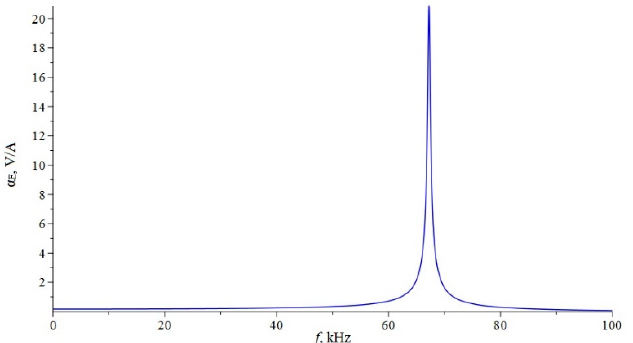
Figure 10. Theoretical dependence of the ME voltage coefficient on the frequency of the alternating magnetic field for symmetrical ME structure Metglas/GaAs of the longitudinal-shear mode.